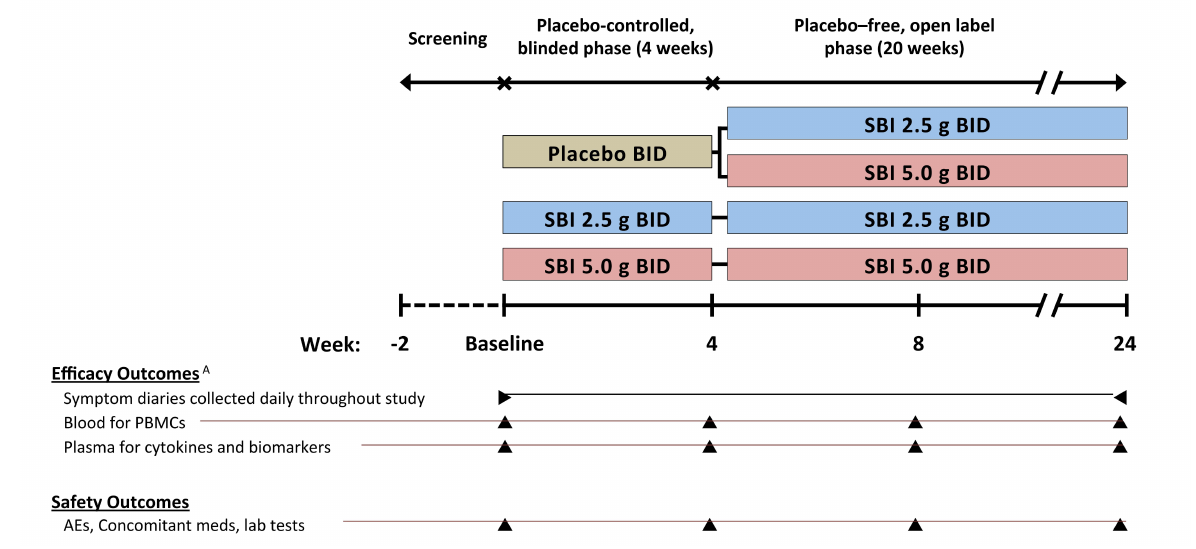
Supplementary Figure 1. Study design and schedule of outcome